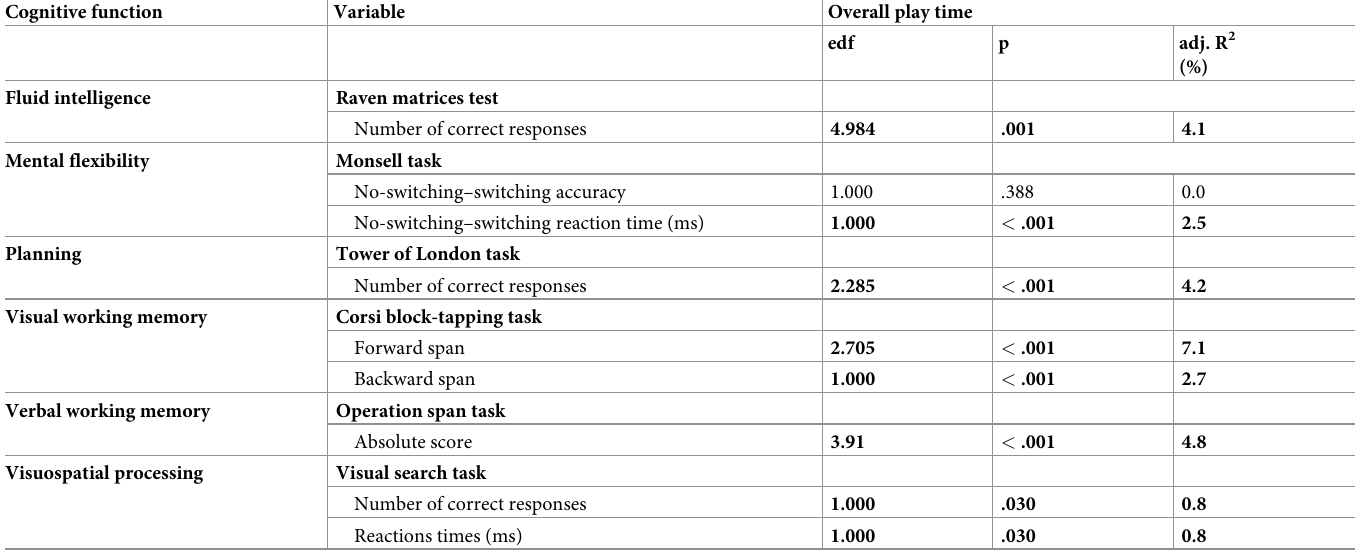
Table 1. Results of the GAMs for overall play